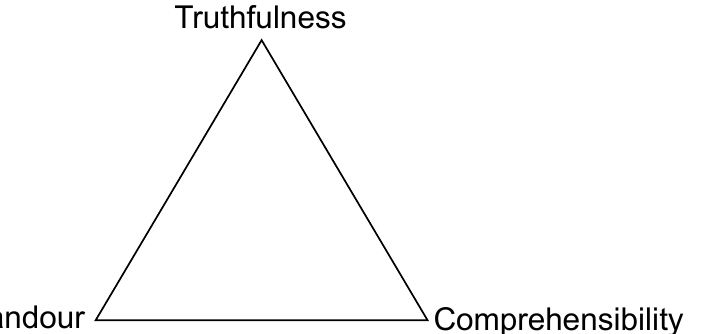
Figure 1. Triangle representing the tensions between the goals of communication.